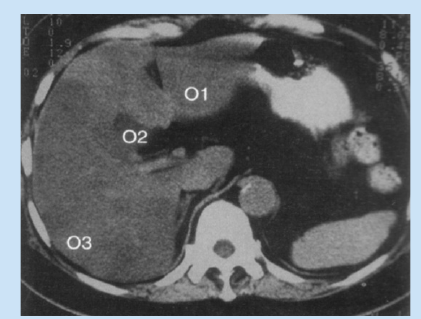
Fig. 1a. Unenhanced CT of the liver in case 1 demonstrates multiple focal low density regions in both lobes of the liver. Region of interest 1 over the fatty left lobe measured 10 HU while region of interest 2 over the right lobe measure 40 HU in keeping with focal fatty infiltration.